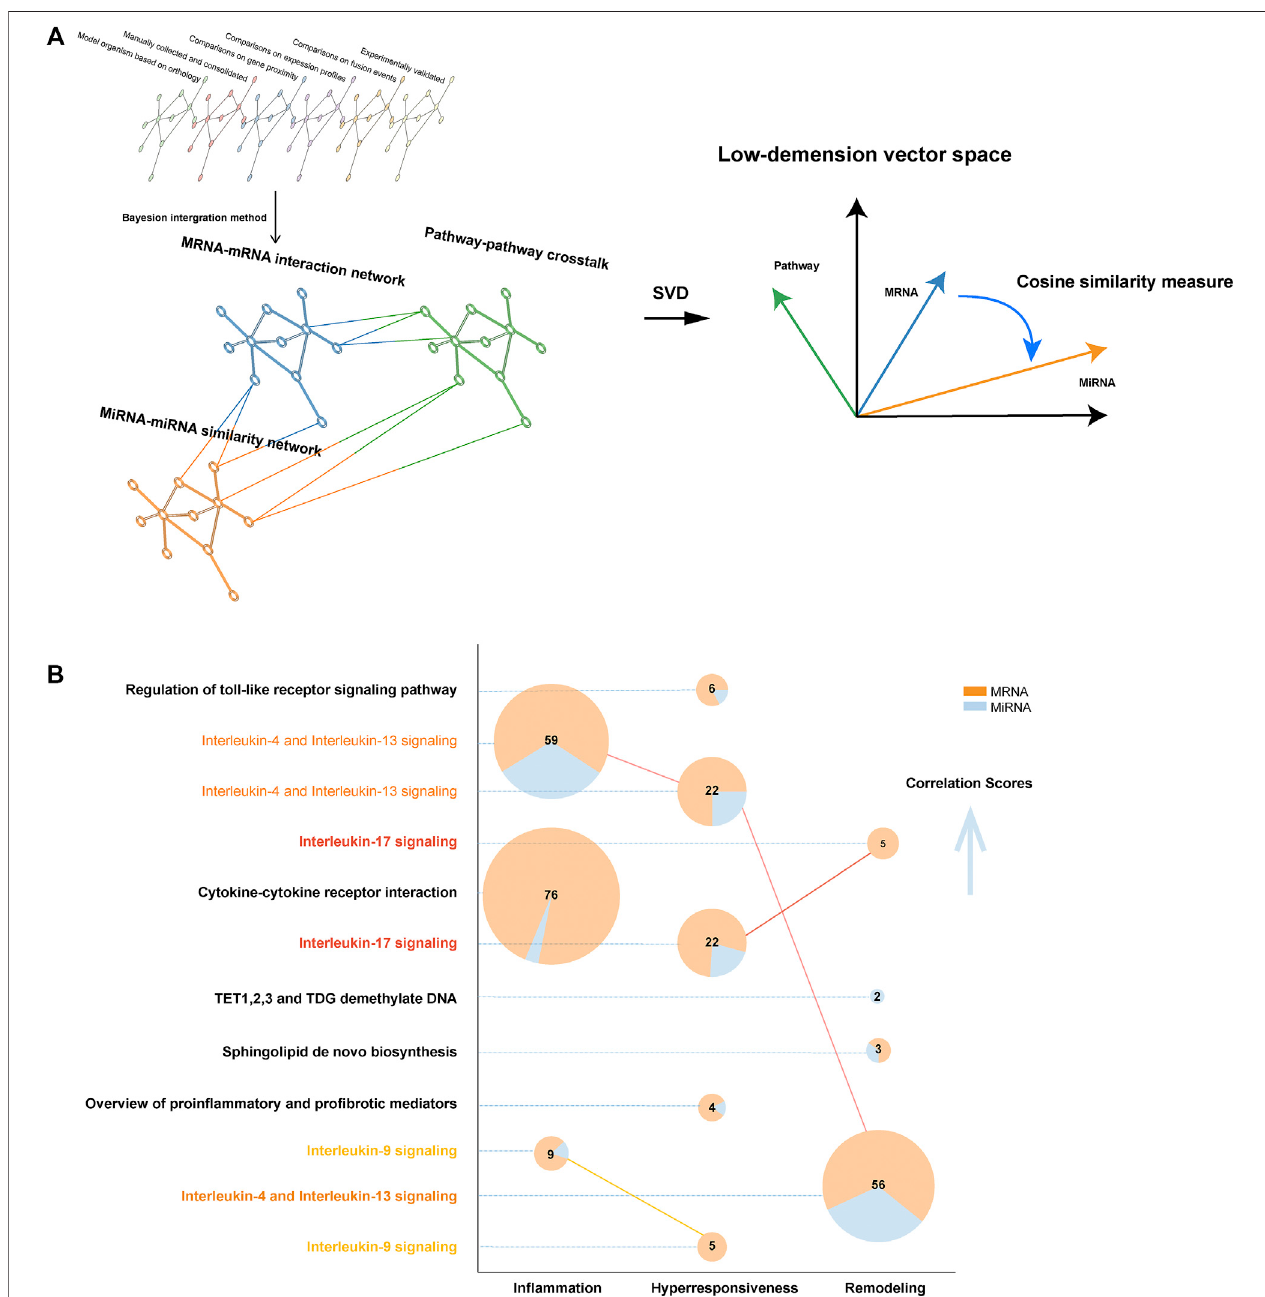
FIGURE 2 | The structure of MIMP and pathway result exhibition. (A) The structure illustration of complex multiplex-heterogeneous network embedding in MIMP. (B) Robust risk pathways of disease characteristics. The number of genes mapping to pathways was directly labeled and the distribution of diverse gene types was color-coded. Pathways that were statistically signi fi cant in multiple disease features are highlighted via colored names and linked to the pie plot. The vertical axis from bottom to top shows the ordering of the empirical p -values from large to small, that statistical signi fi cance tends to increase.